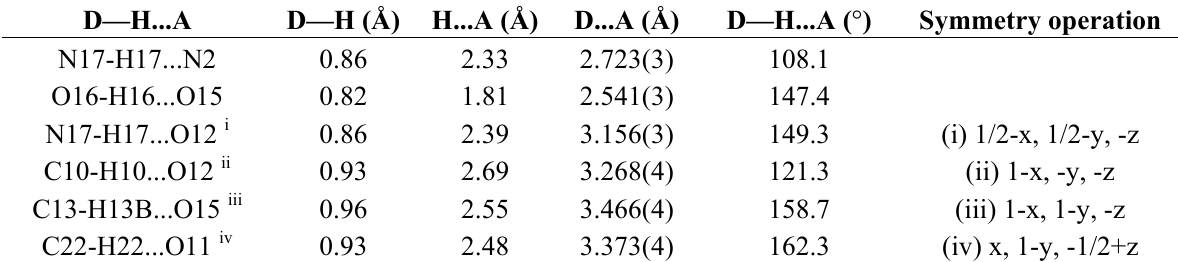
Table 6. The programs ORTEP-3 [39], SHELXS/SHELXL [52] were used within WinGX [53] software package. Table 6. Intramolecular and intermolecular hydrogen bonds and weak